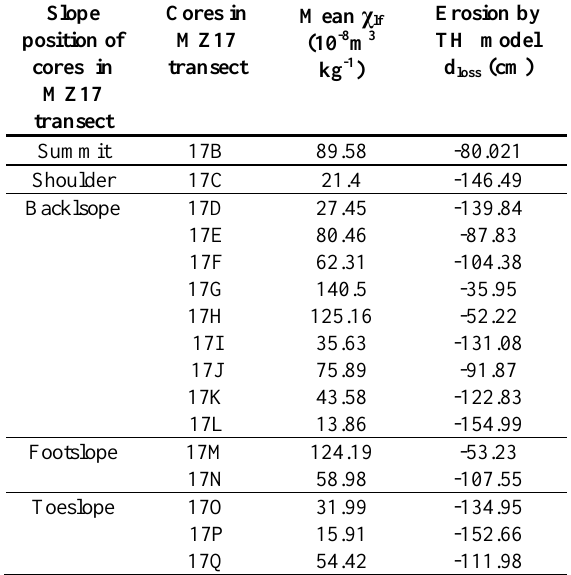
Table 2. Soil loss in different soil profiles after homogenization (in cm) in MZ17 transect